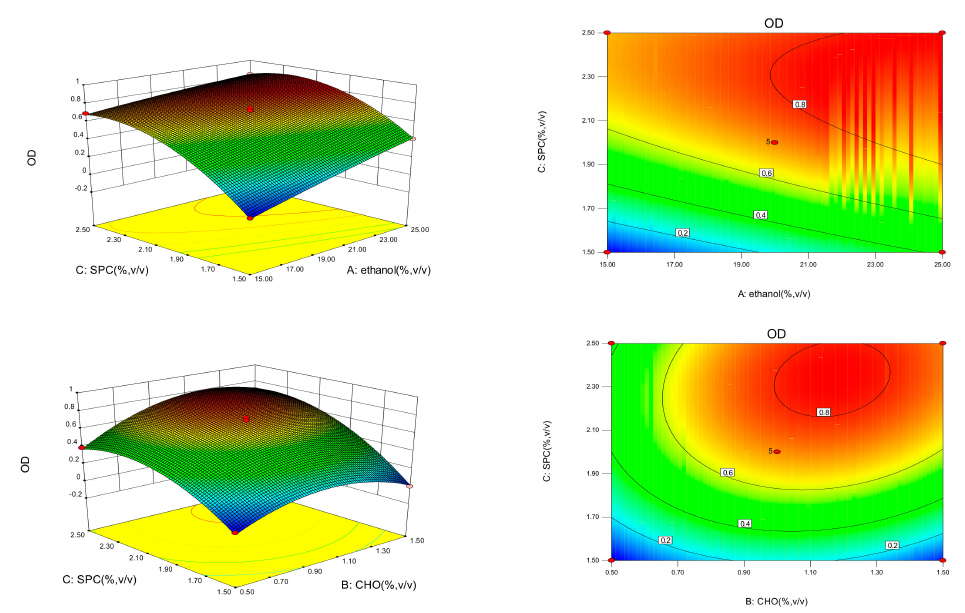
Figure 1. The response surface and contour plots of the fitting equations of the concentrations of ethanol (A), CHO (B) and SPC (C) on OD (Y).